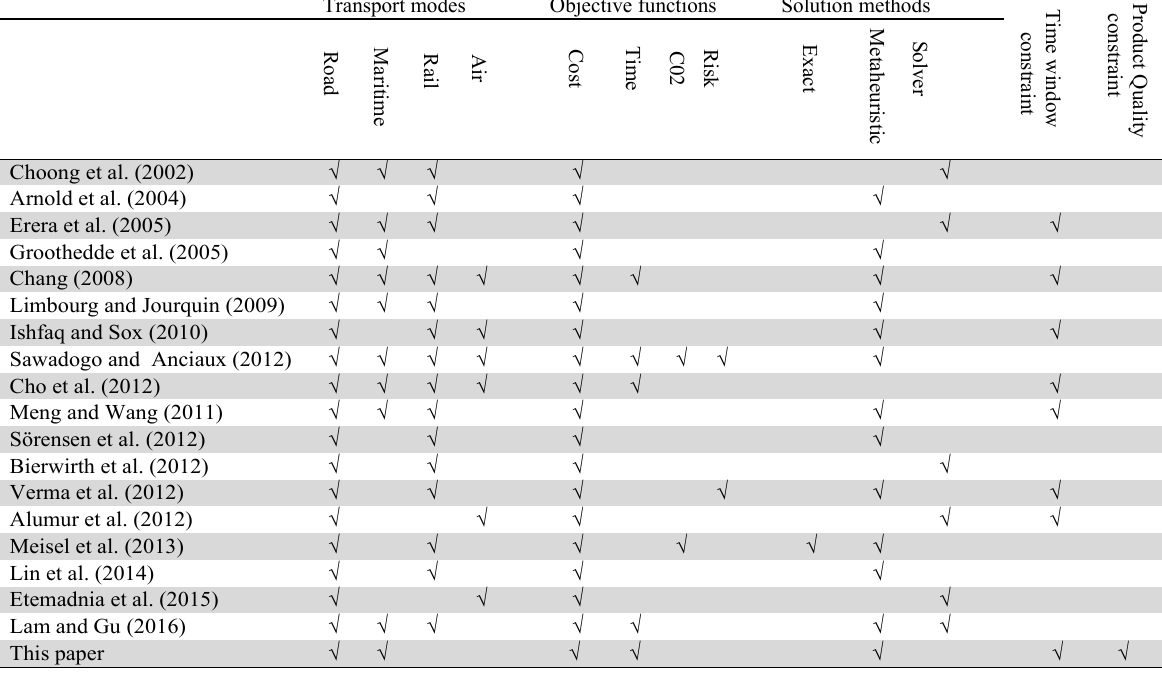
Some related papers of intermodal transport Transport modes Objective functions Solution